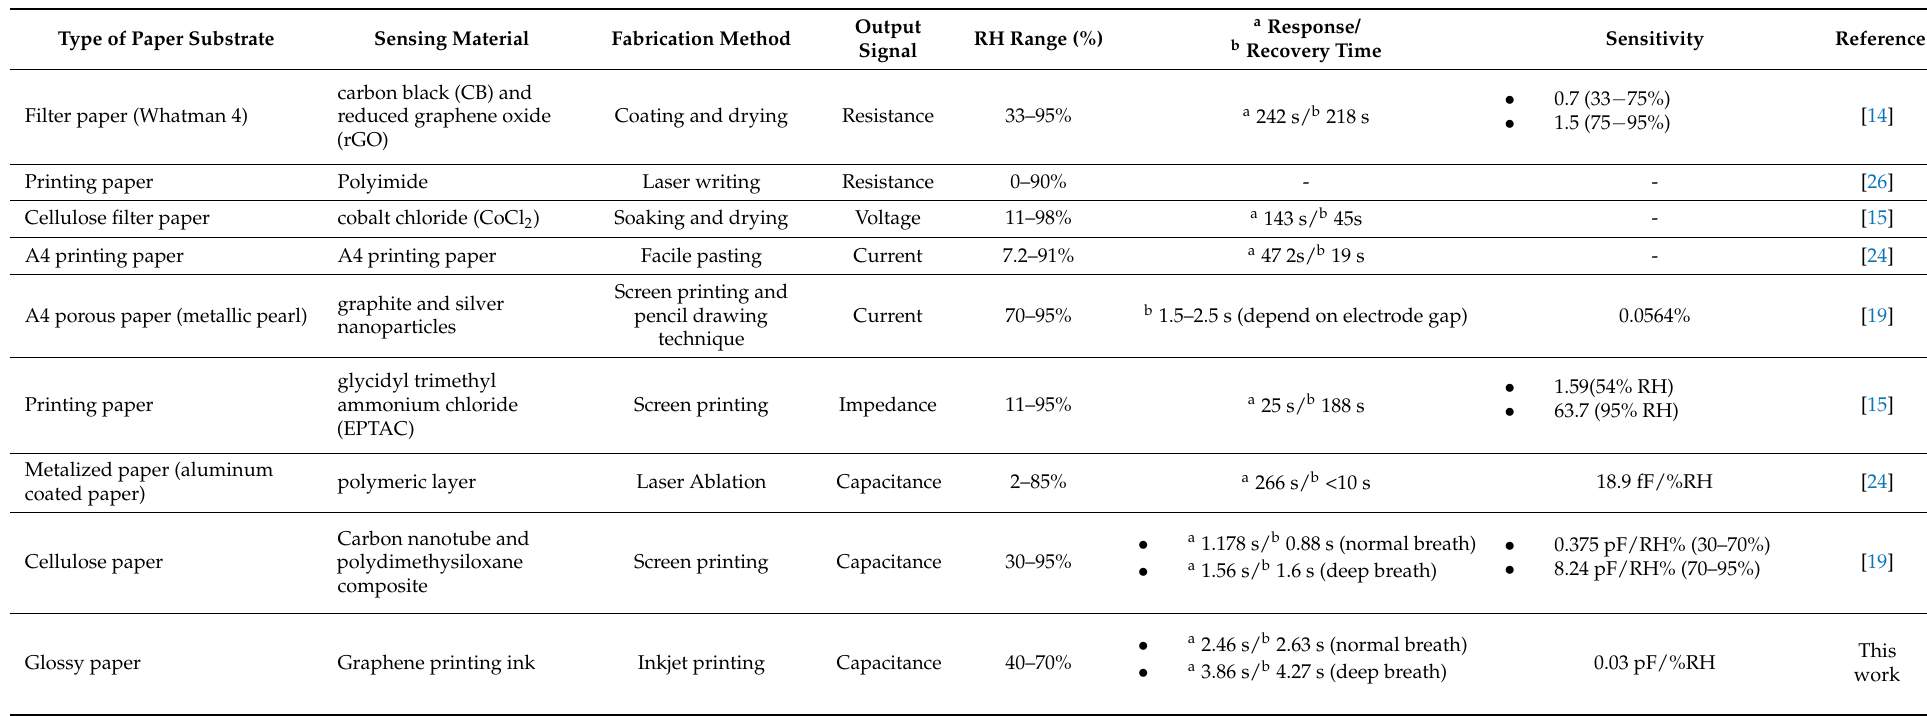
Table 1. Comparison of proposed sensor with other reported paper-based humidity sensor in the